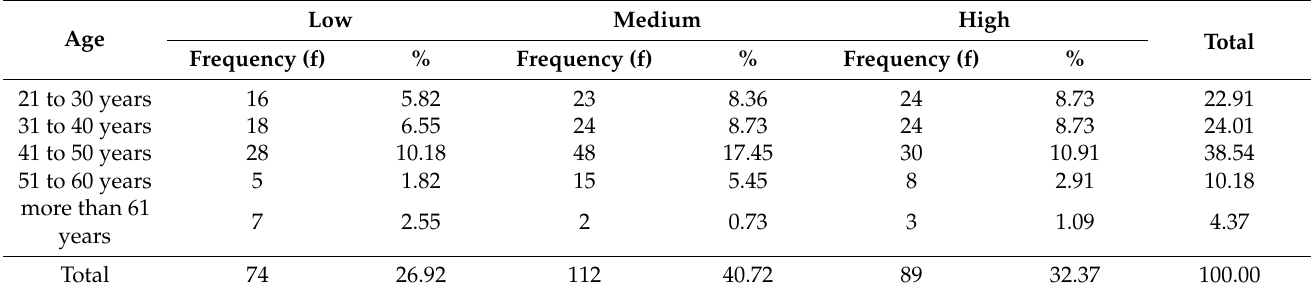
Table 6. Level of the remote work variable in Peruvian workers during the COVID-19 pandemic, according to age.